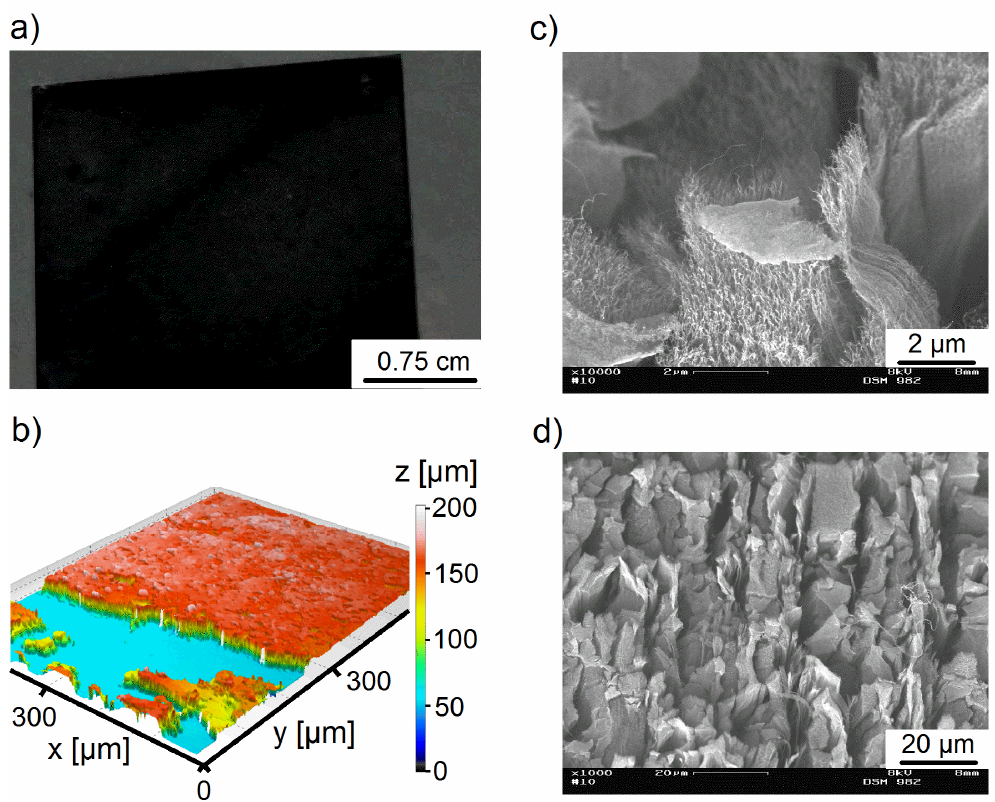
Figure 4. Photograph of VACNT (dark black area) transferred to primer-coated aluminum foil (grey area) by hot calendar with too high a pressing force (400 N) ( a ). Confocal microscopy image of the transferred film ( b ). SEM images of transferred film with higher ( c ) and lower ( d )